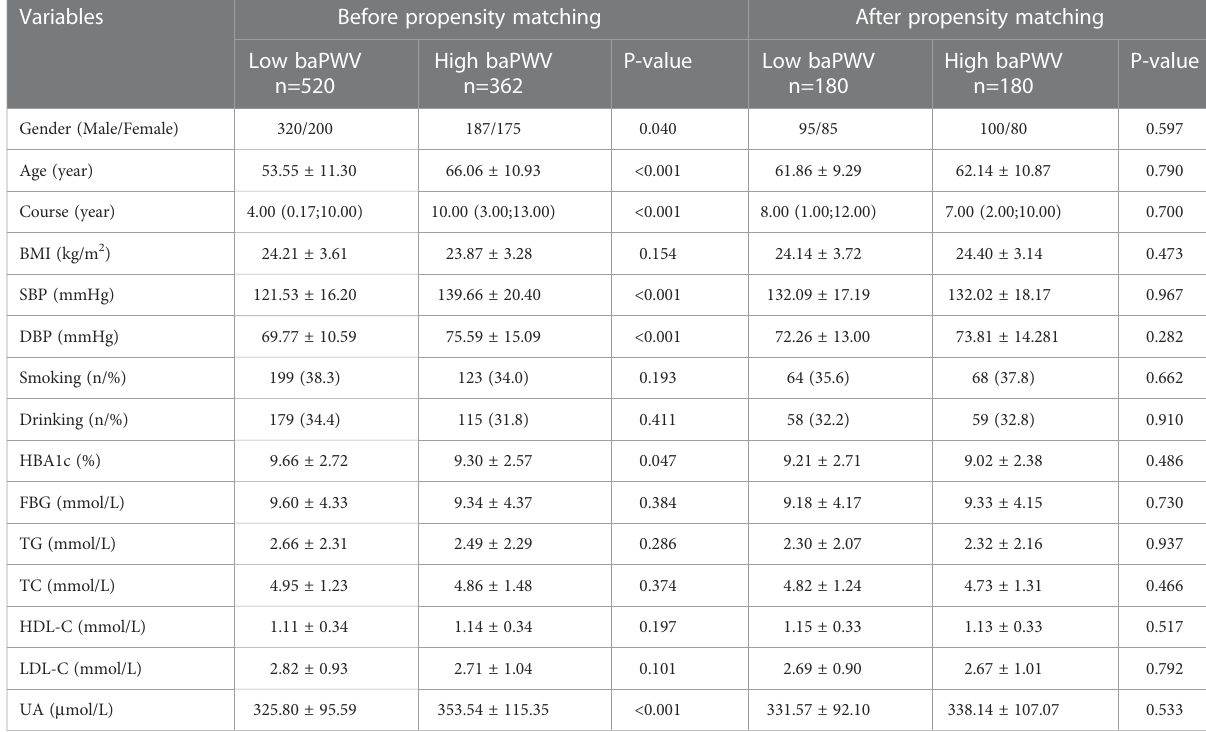
TABLE 2 Patients ’ pro fi les propensity score